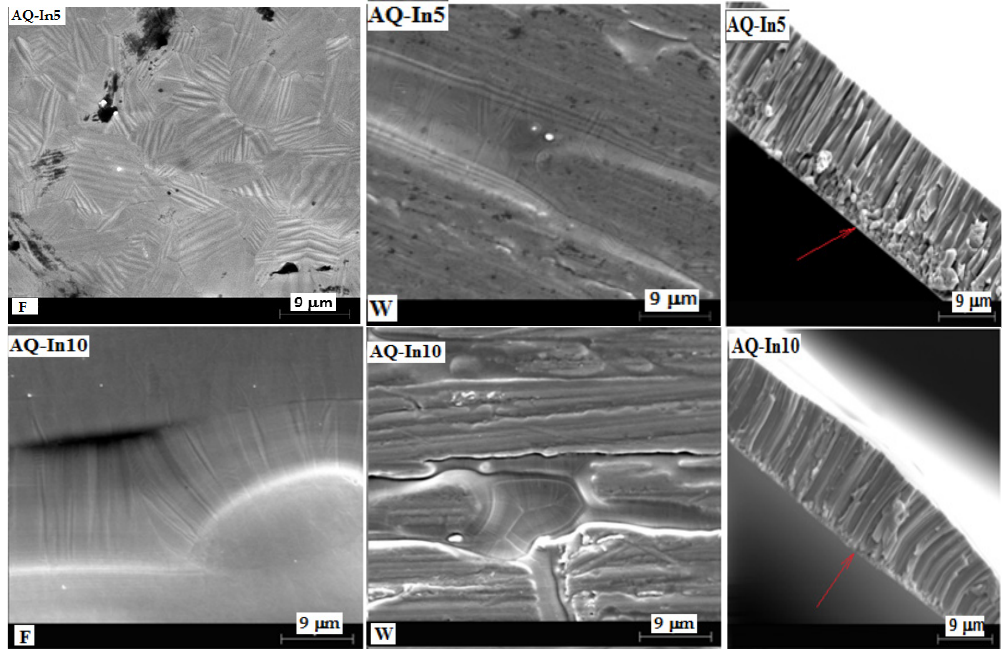
Figure 4. SEM micrographs of the free surface ( F ), wheel surface ( W ), and cross section ( right ) of the AQ ‐ In5 and AQ ‐ In10 ribbons. The red arrow indicates the wheel contact surface. Table 2. Elemental analysis and e/a ratio (theoretical and experimental) of the as quenched and heat ‐ treated In5 and In10 ribbons.